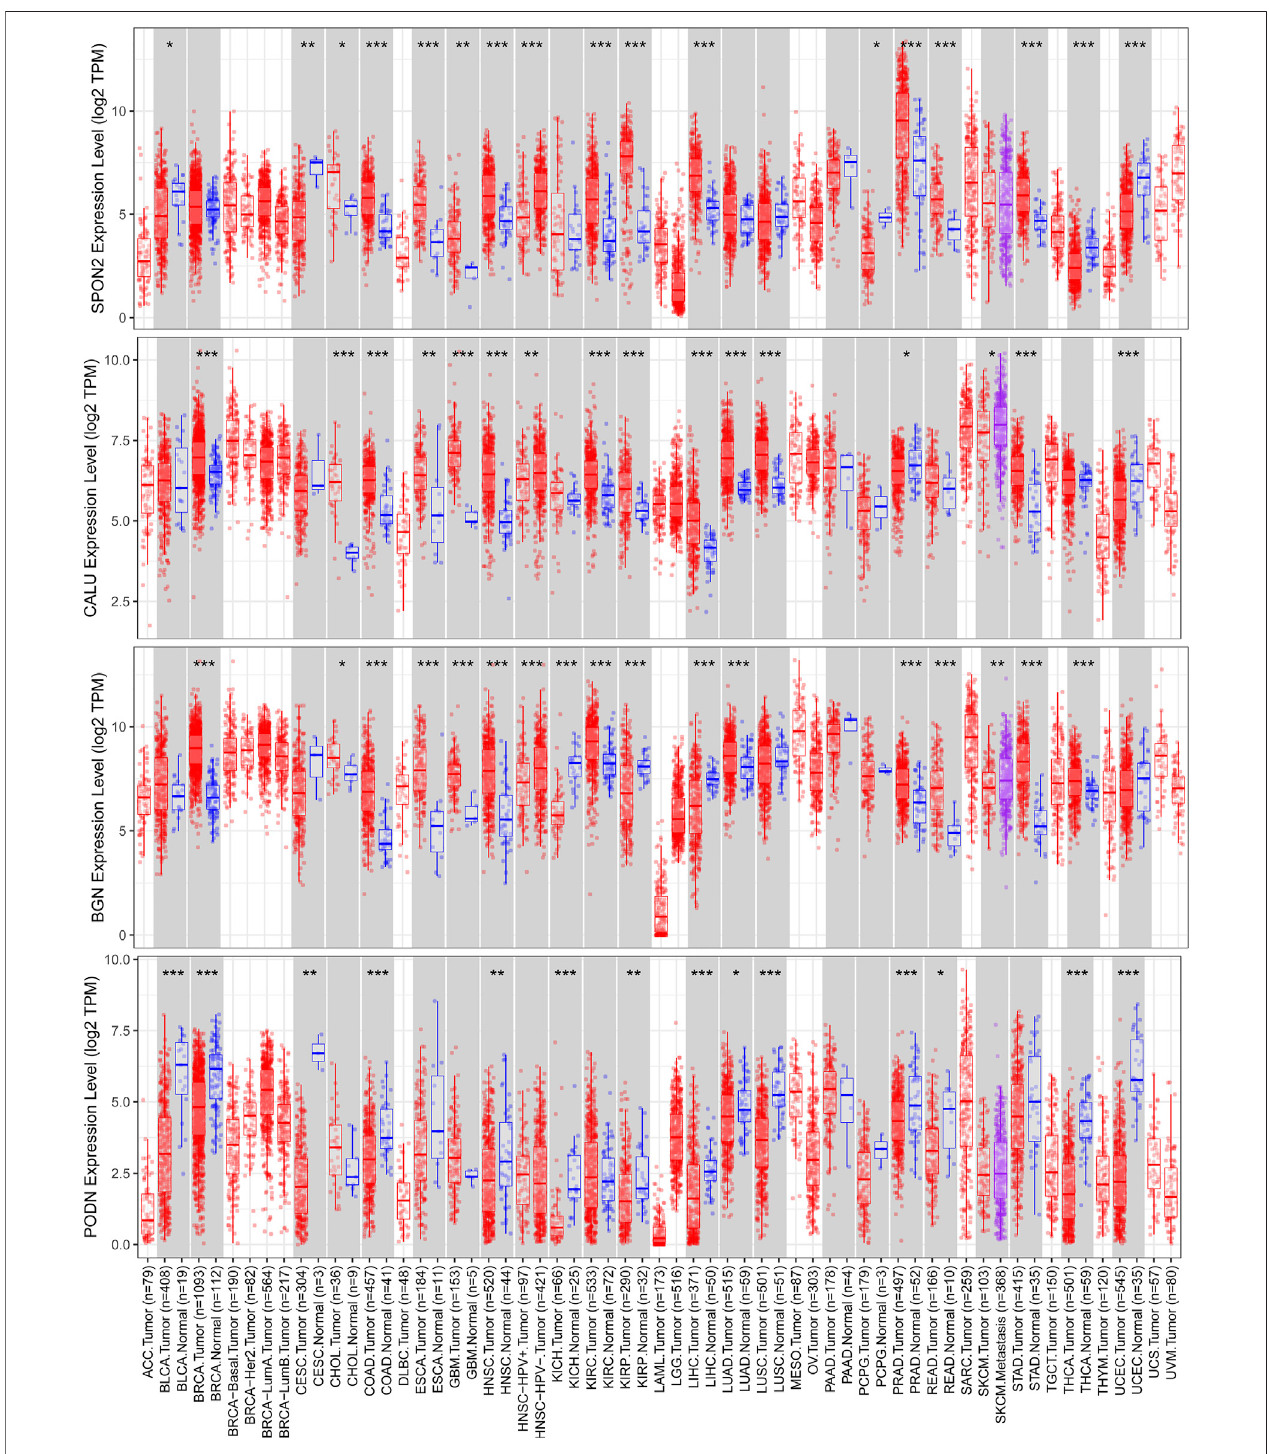
FIGURE5| MultivariableCoxproportionalhazardpatternshowedthatBcells,CD8 + Tcells,anddendriticcellsofimmunein fi ltratessigni fi cant( p < 0.05)inHNSCC suggesting that these immune cells signi fi cantly stimulate the prognosis, it is signi fi cant for further exploration.